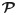
One example of event location algorithm based on α-hull: Those sensors at the marginal area of the yellow circular are defined as the set P.Three sensors u1, u2, u3 are selected randomly into the set P1 initially. After execute α-ELA algorithm, the kindling point will be located.